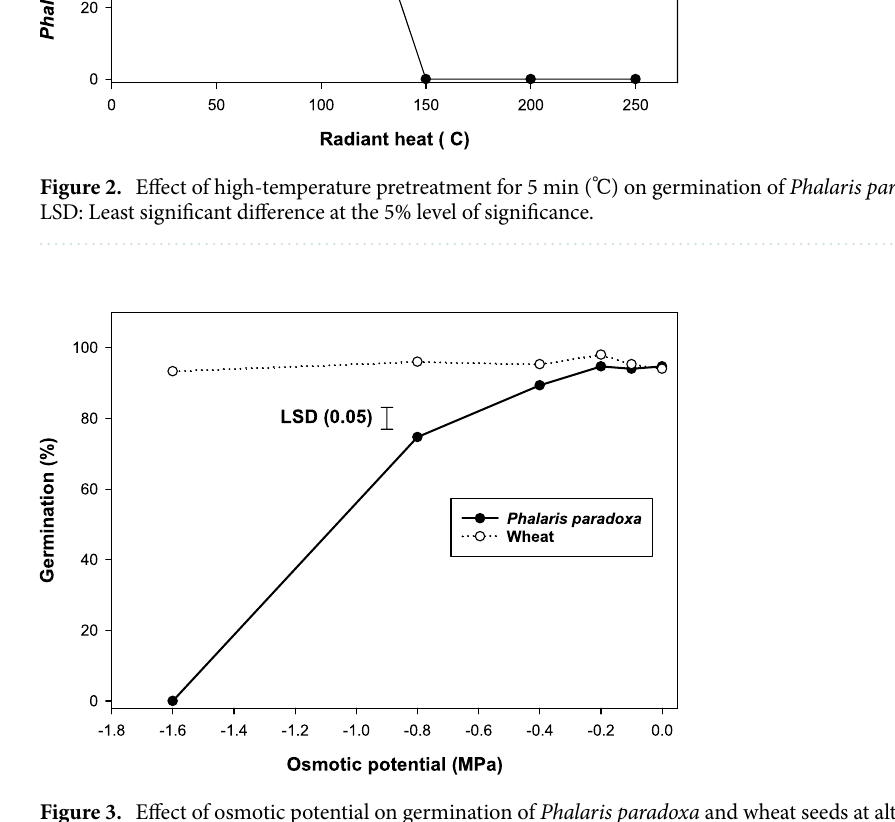
Figure 3. Effect of osmotic potential on germination of Phalaris paradoxa and wheat seeds at alternating day/ night temperatures of 20/10 °C under 12 h photoperiod. Seeds were incubated for 21 d. LSD: Least significant difference at the 5% level of